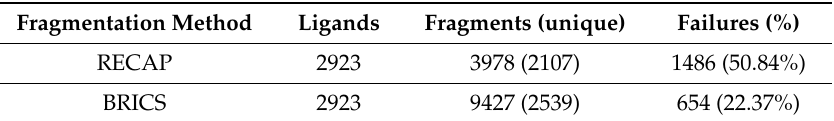
Table 1. Results of BRICS and RECAPS in the fragmentation of a non-redundant collection of ligands derived from the LIBRA